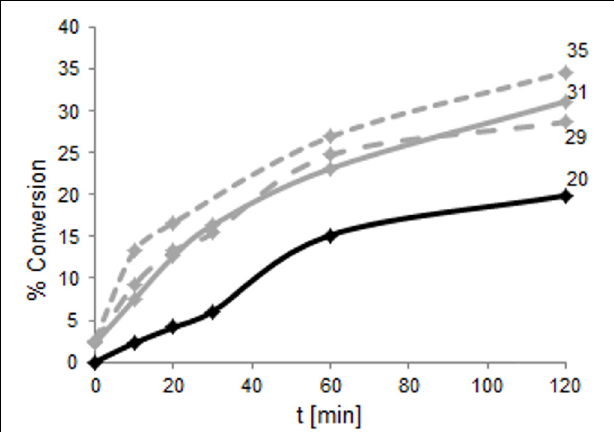
FIGURE 7 | Time course of the product formation of TM1459 (1 mg total protein) wild type (black) and -C106Q (gray, full line), -I49A/F94A (gray, dashed line), and -C106V/L107 ∗ (gray, dotted line) over the first 2 h of the bioconversion reaction with 50 mM α -methylstyrene and